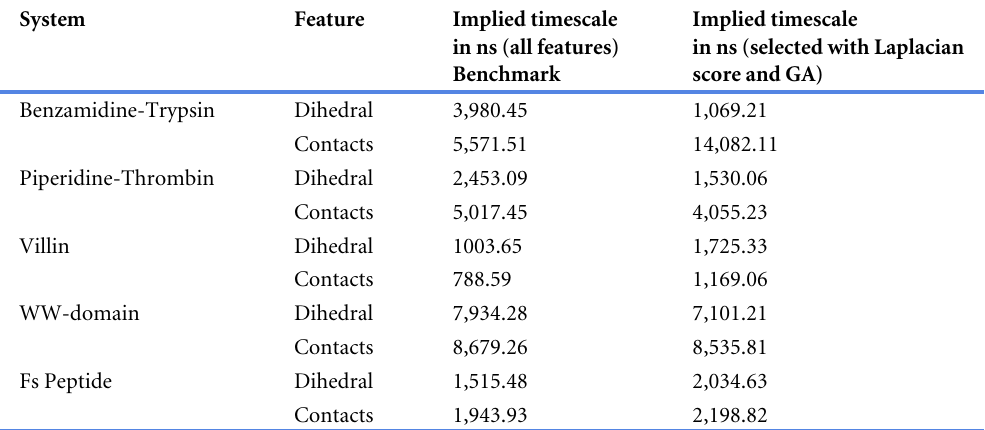
Table 4 Comparison of implied timescale between different features and the efficiency of MSM im- proved with feature selection using Laplacian score and